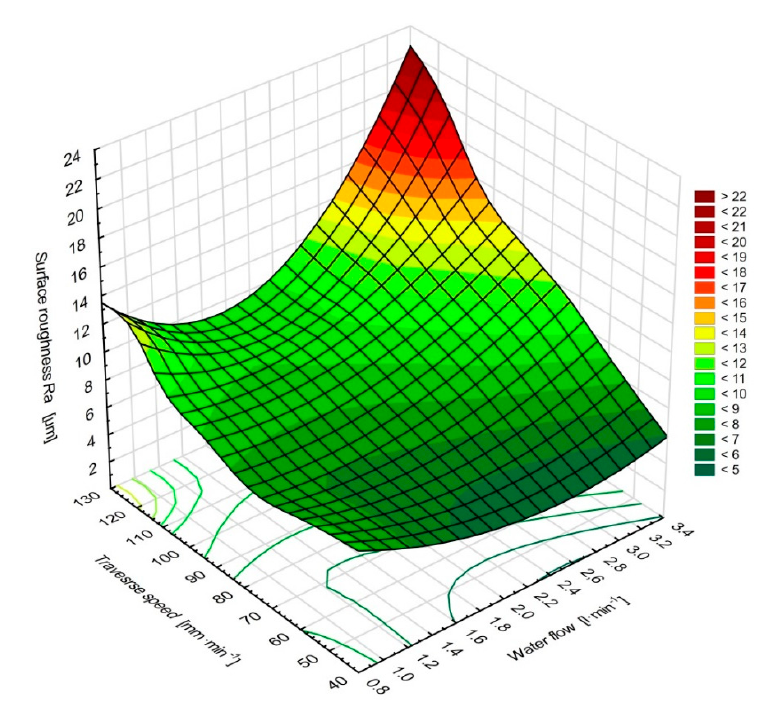
Figure 8. Dependence of surface roughness Ra on the variation of cutting head feed rate and high-pressure water flow.